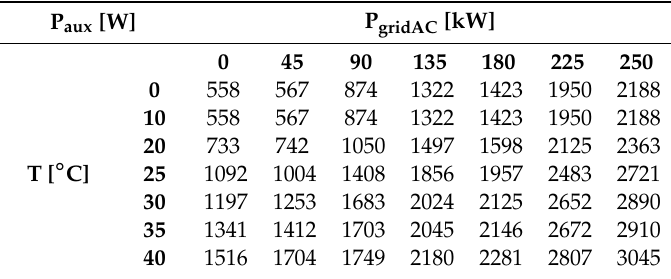
Figure 12. Auxiliaries' power.